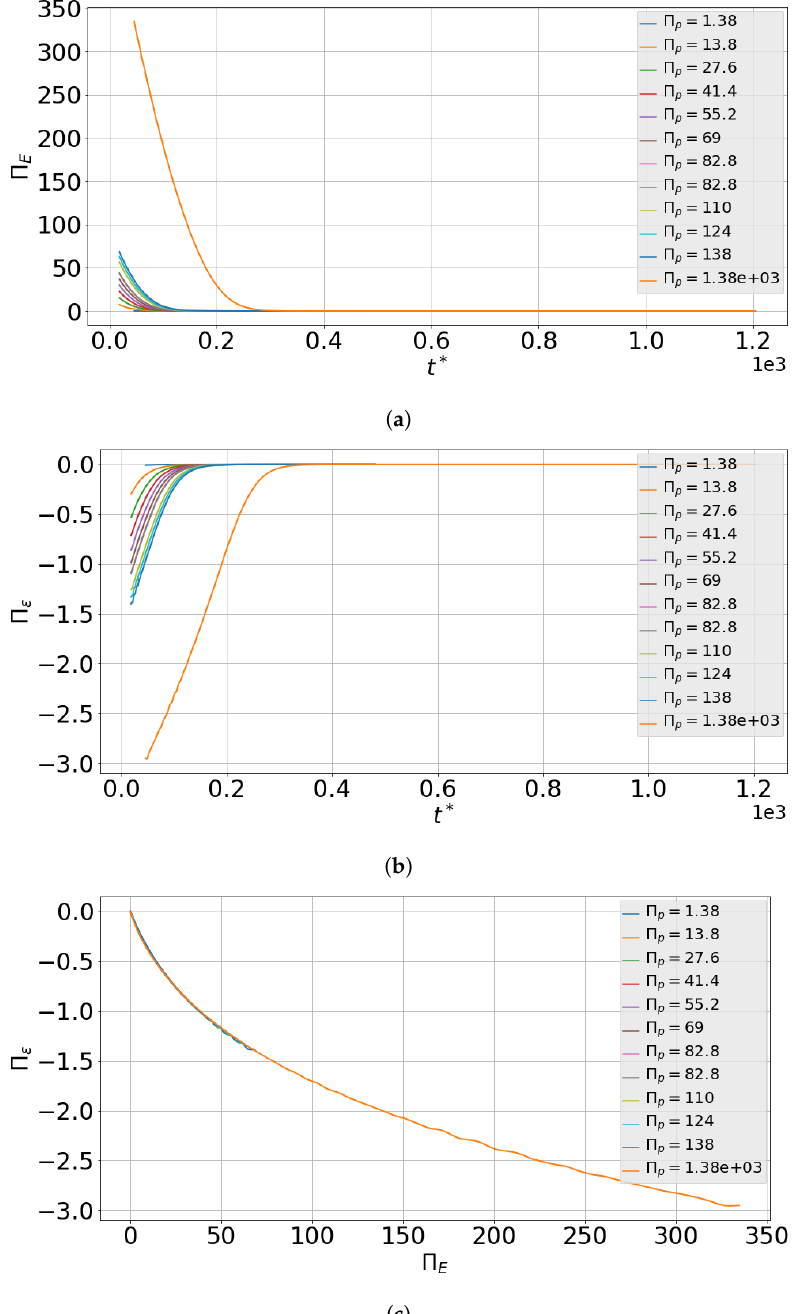
Figure 8. Variation of non-dimensional energy and energy dissipation rate for different values of Π p while keeping Π S = 0.64 and Π ν = 0.0114 constant: ( a ) variation of Π E with non-dimensionalized time t ∗ ; ( b ) variation of Π ε with non-dimensionalized time t ∗ and ( c ) variation of Π ε with Π E